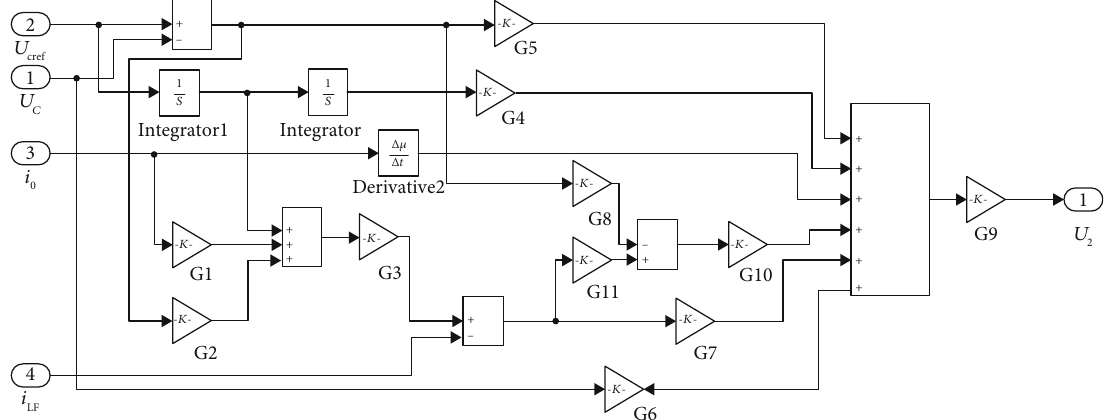
Figure 11: Internal blocs of back-stepping control 2.